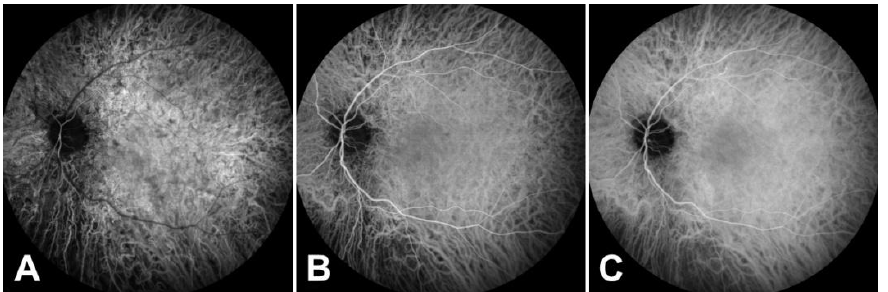
Figure 2. Indocyanine green angiography showing atrophy of the choriocapillaris in the affected area: early ( A ), middle ( B ), and late phases ( C ).